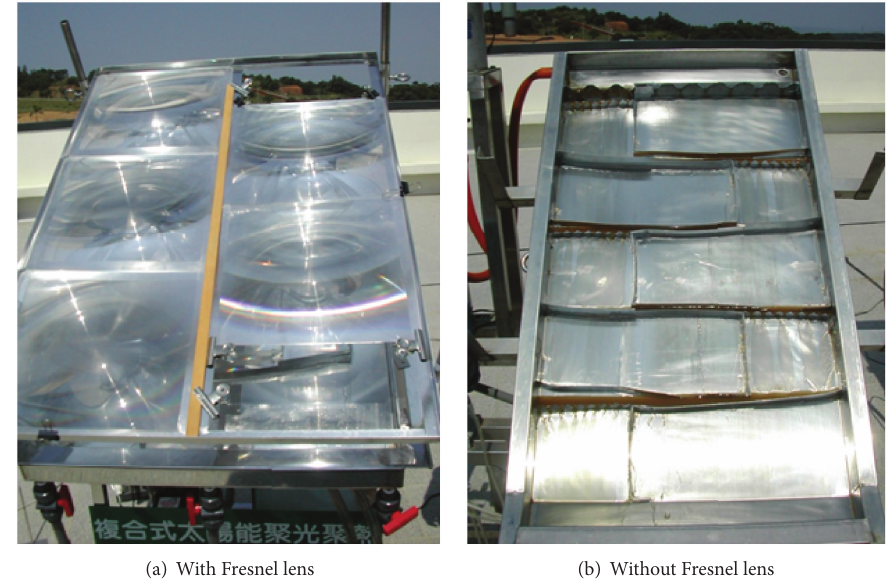
Figure 1: Photograph of pilot-scale solar inclined plate curvature channel (IPCC) reactor.